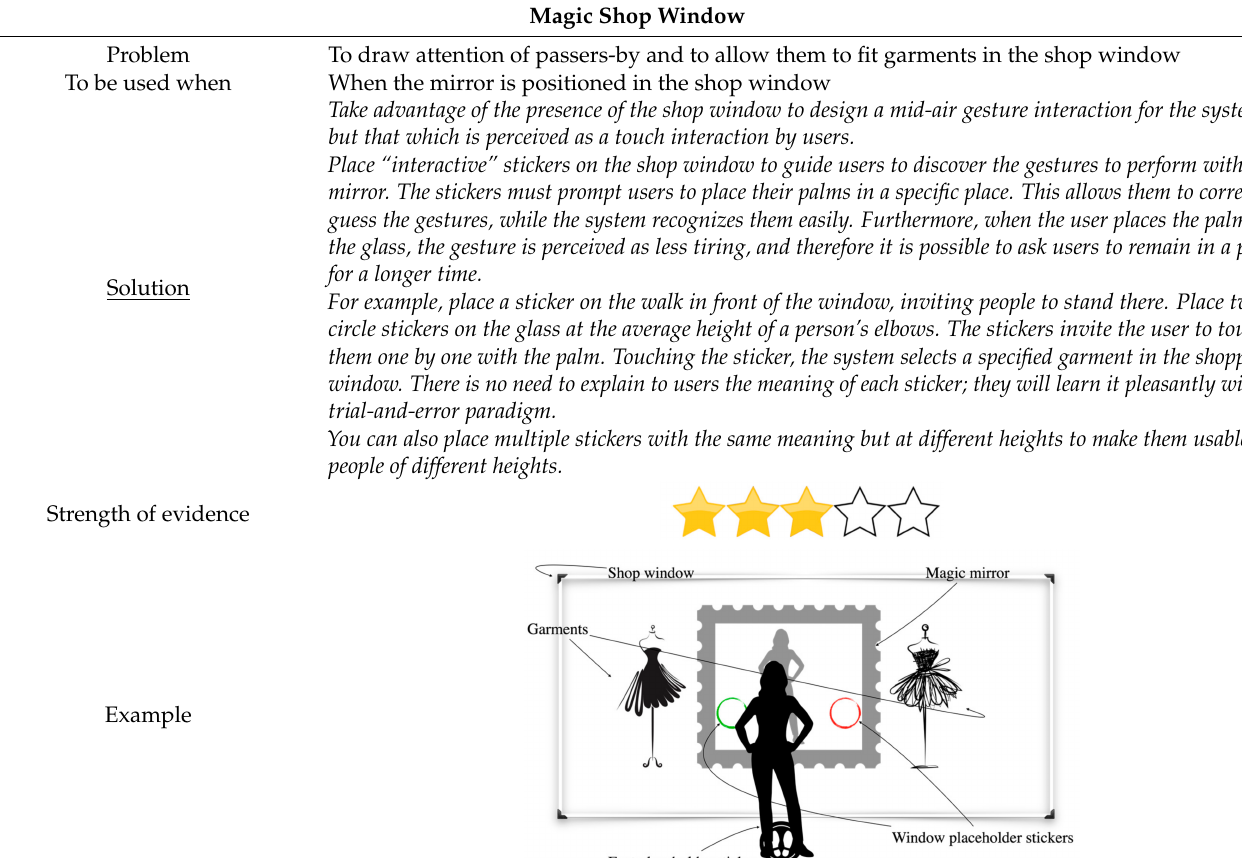
Table 11. Magic shop window patterns. Magic Shop